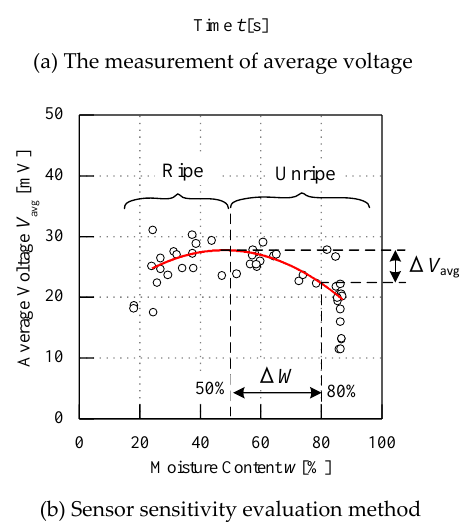
Figure 6. Data evaluation.